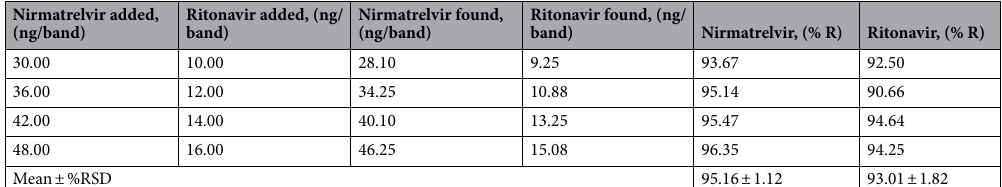
Table 5. Determination of nirmatrelvir and ritonavir in the spiked human plasma samples.